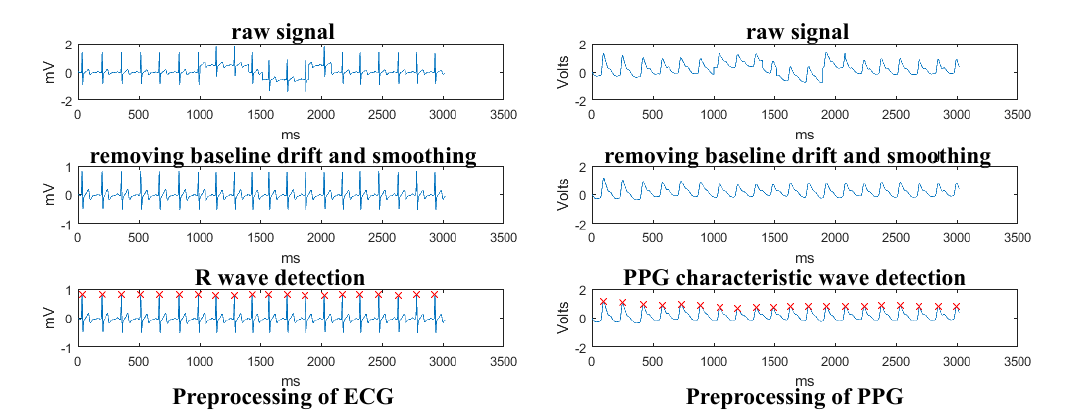
Figure 7. The preprocessing of ECG and PPG signals.